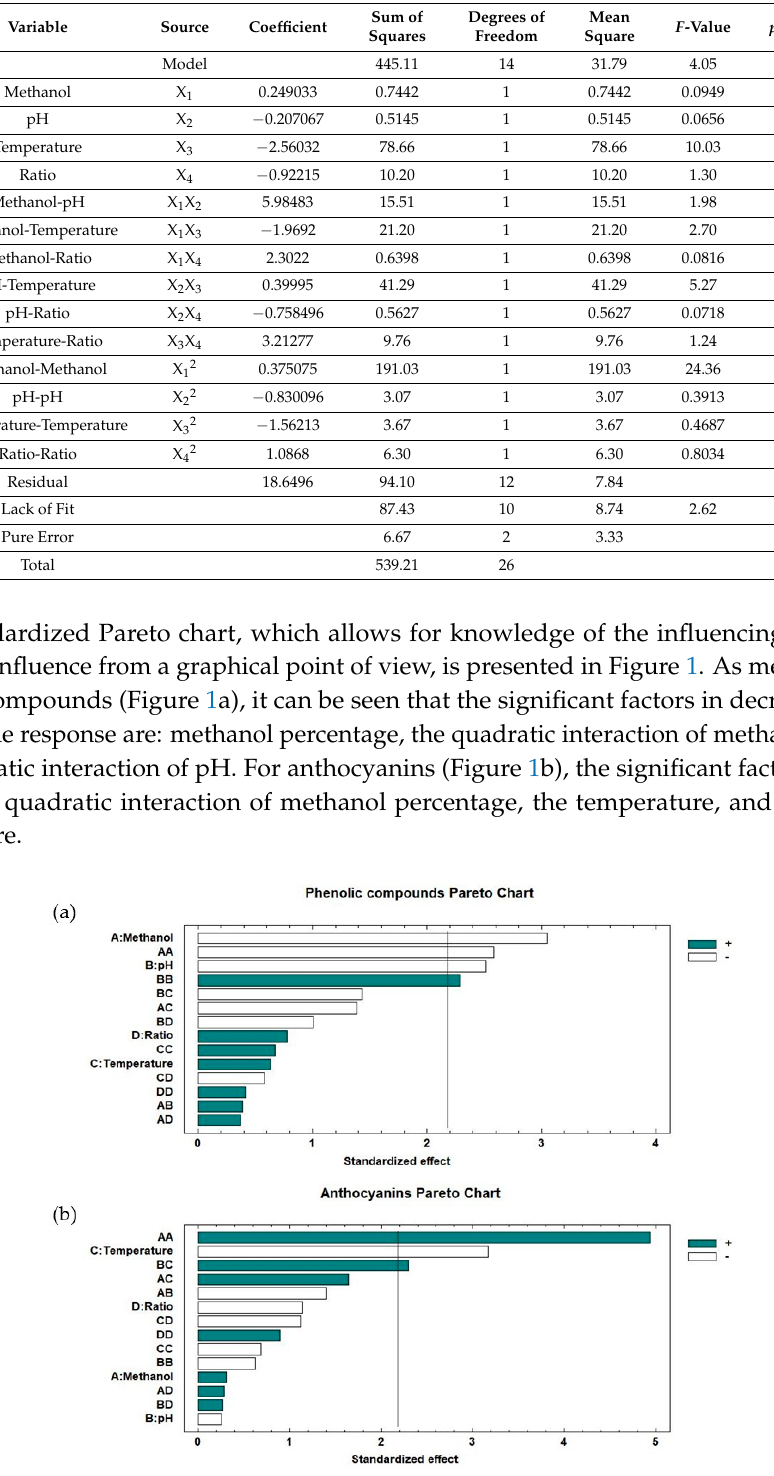
Table 2. Analysis of variance of the quadratic model, adjusted to the extraction of total anthocyanins. The ranges studied for each parameter were: methanol (50–100%), pH (2–7), temperature (50–100 ◦ C), and sample–solvent ratio (0.5 g/10 mL–0.5 g/20 mL).